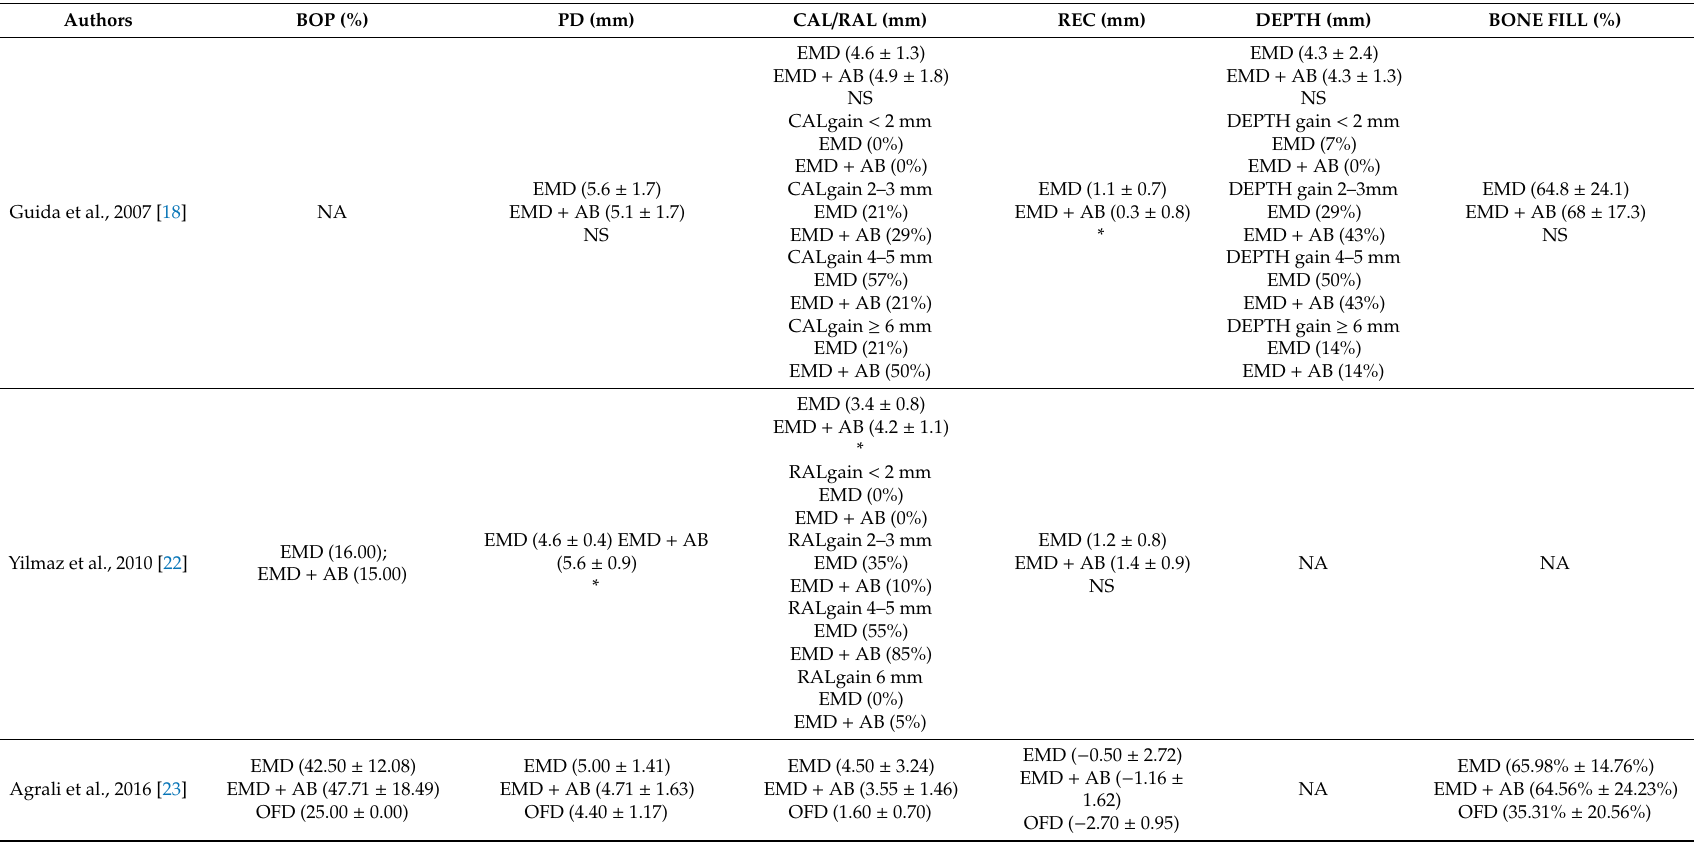
Table 7. Changes in BOP, PD, CAL, REC, RAL, DEPTH, and bone